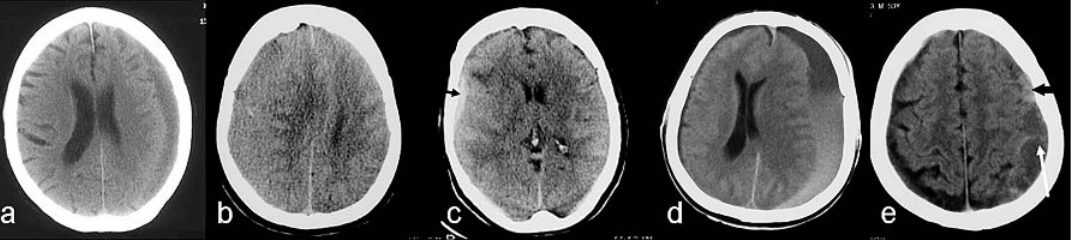
Figure 2 CT density patterns. a. Hypodense subdural haematoma. b. Isodense subdural haematoma. c. Hyperdense subdural haematoma (arrow). d. Mixed density left frontoparietal haematoma with levelling. e. Mixed density haematoma with hyperdense component (black arrow), and intrahaematomal membrane (white arrow).